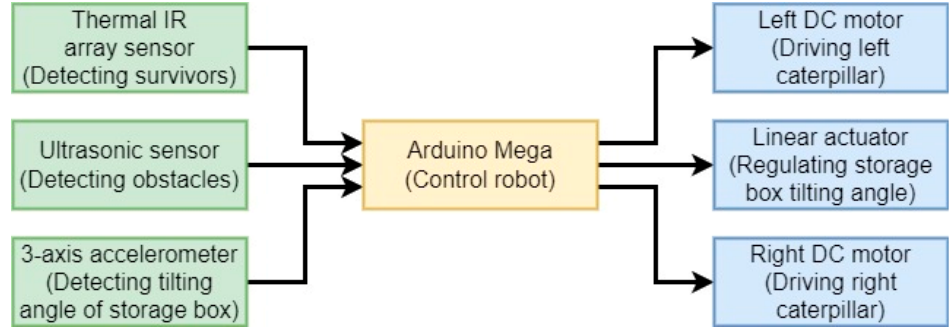
Figure 2. Overall block diagram and roles among the components.